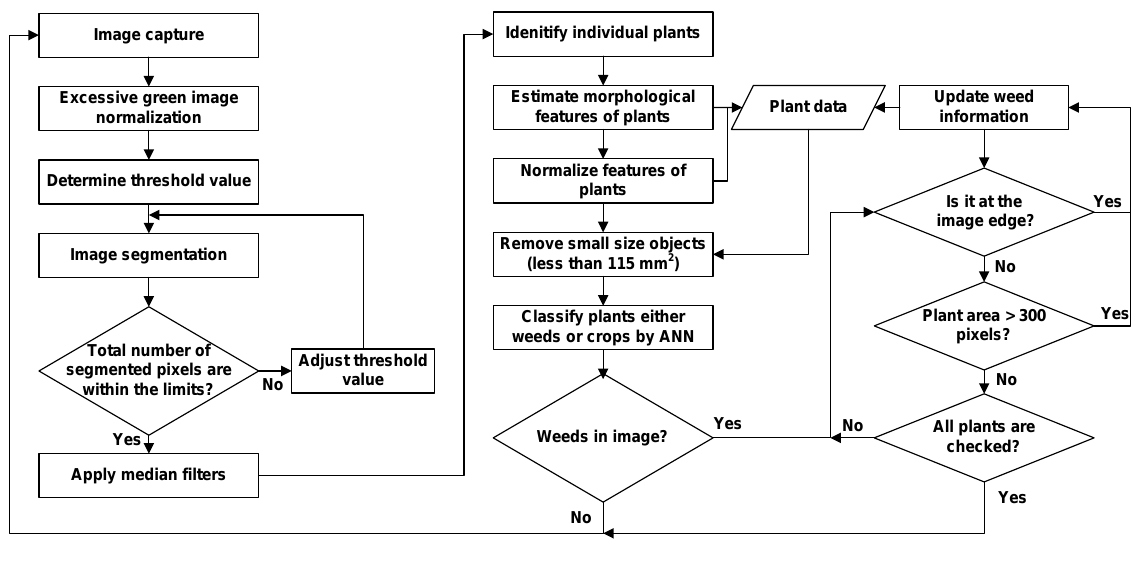
Figure 4. Flowchart for the image processing algorithm.